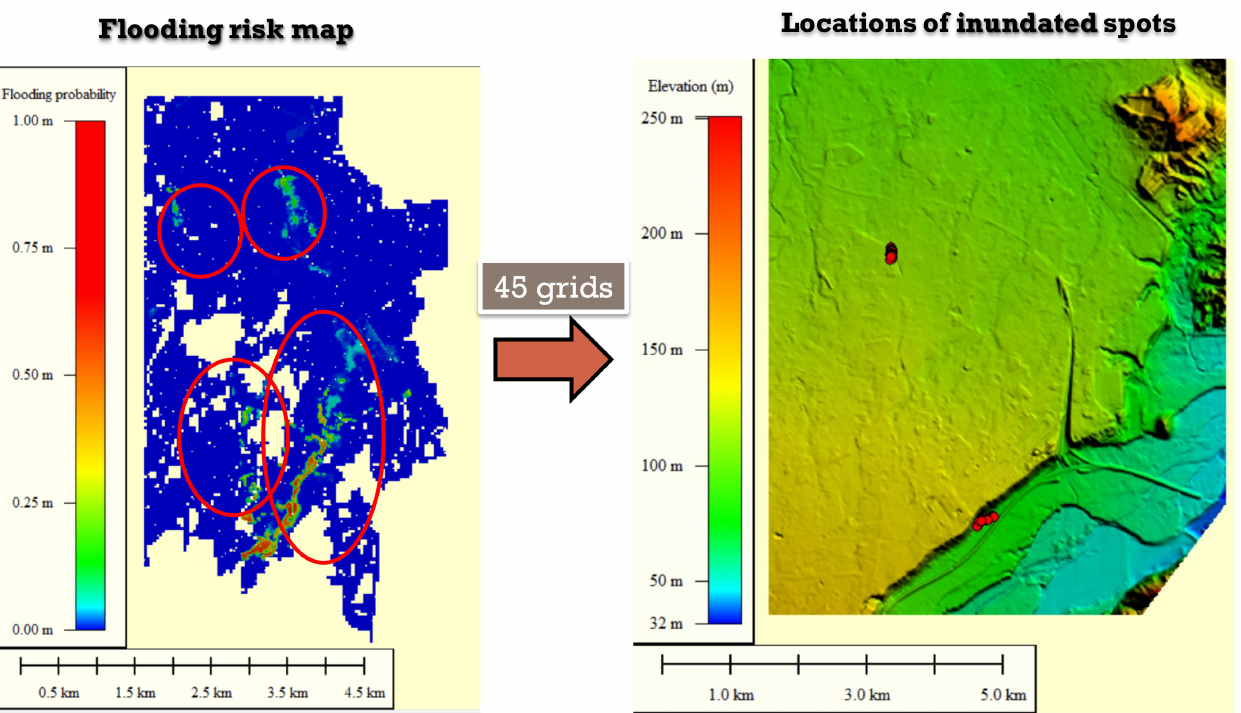
Figure 7. Flooding risk map and locations of potential inundated spots within the study area (the Nankan River